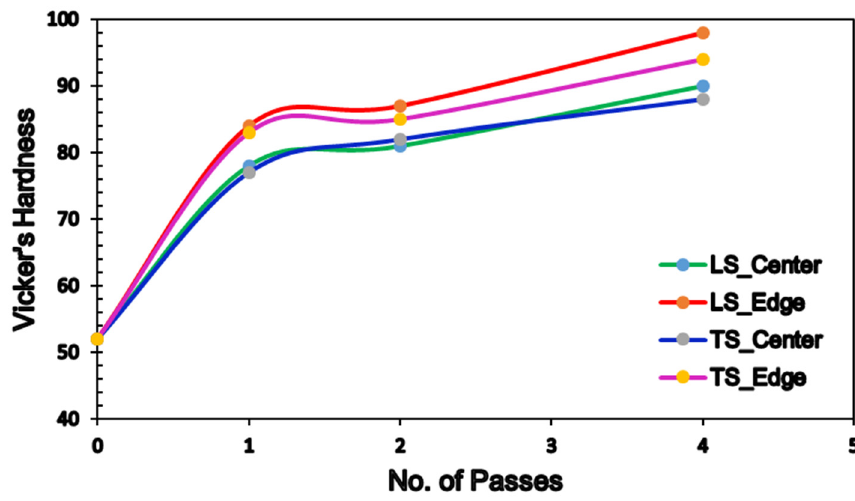
Figure 15. Distribution of VH across LS and TS of ZK30 billets as a function of number of passes. Table 4. Hardness distribution along the LS and TS and the tensile properties of ZK30 billets before and after ECAP processing. HV Yield